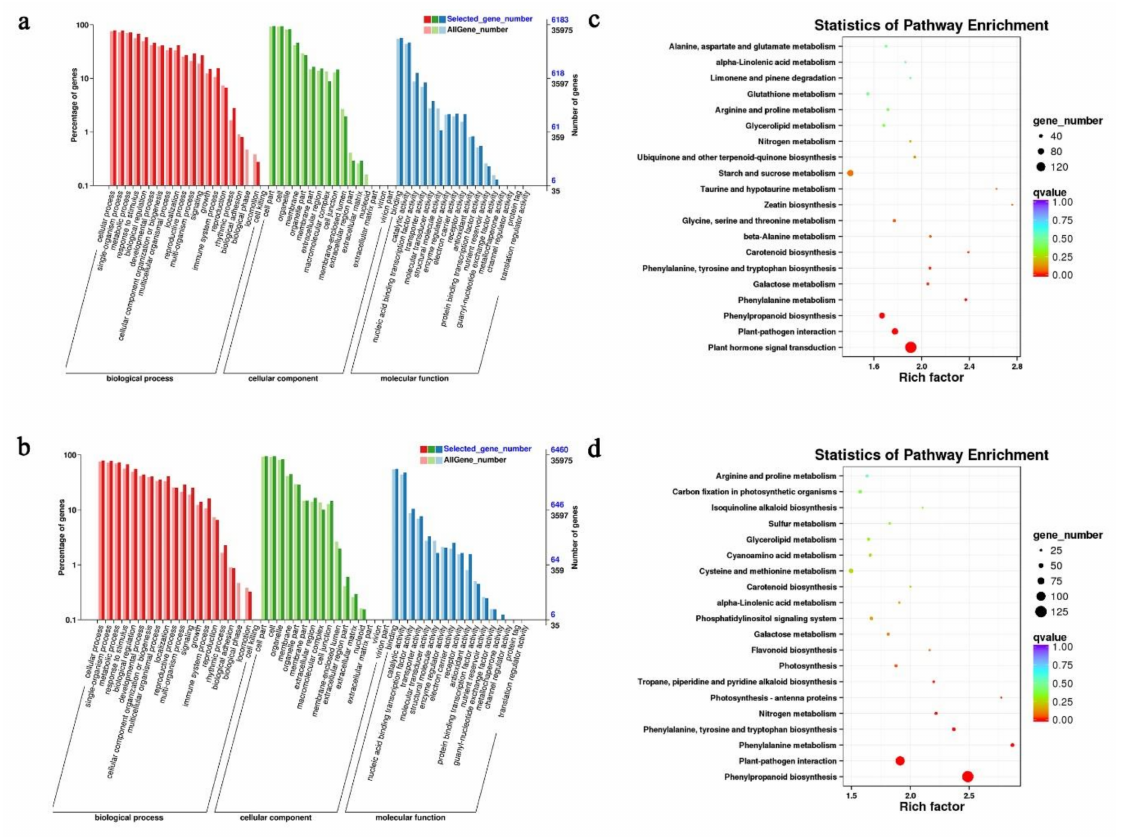
Figure 4. ( a ) GO enrichment of DEGs of the R-Line and ( b ) S-line, and ( c ) KEGG pathway enrichment of DEGs of the R-line and ( d )